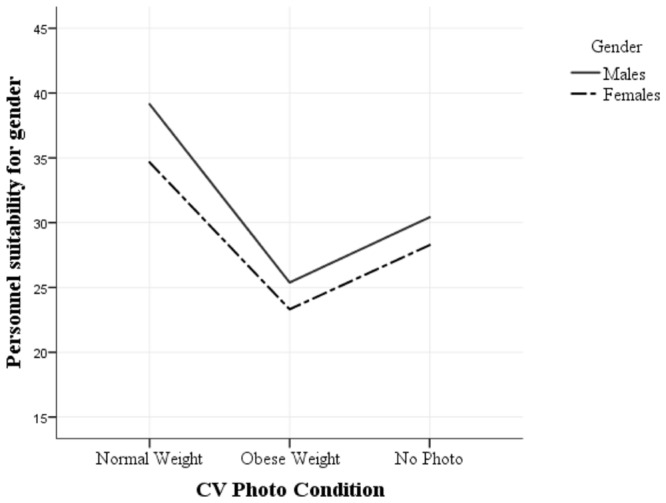
Gender difference across obese, normal weight, and no photo conditions.